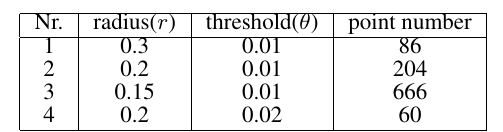
Table 2. Parameter setting for Harris 3D keypoints.